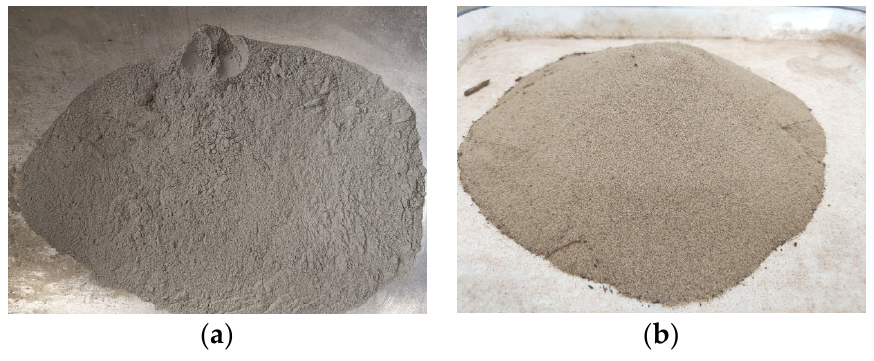
Figure 1. ( a ) fly ash, ( b ) dune sand. Table 1. The chemical composition of concrete mixtures (%).